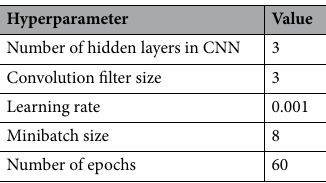
Table 1. Hyperparameter values of the proposed convolutional neural network.